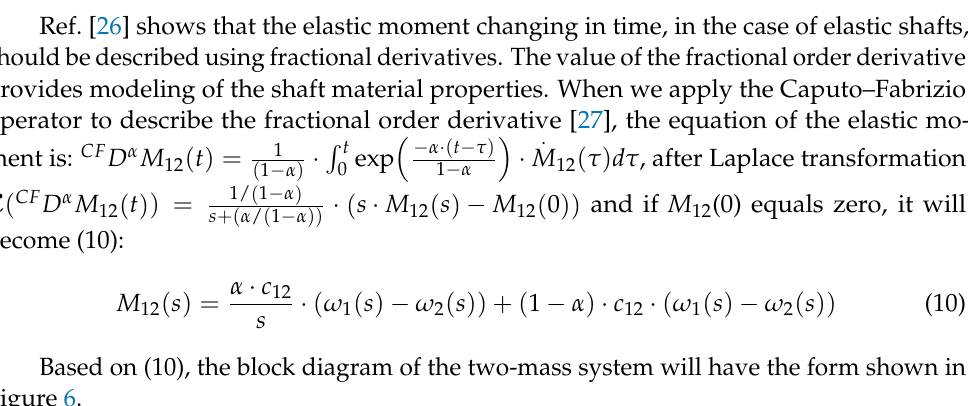
Figure 5. Speed dependencies: __ model with distributed parameters; __ traditional model of a two-mass